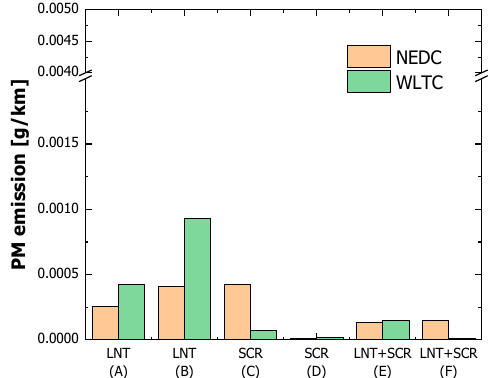
Figure 12. Emission characteristics of test vehicles in New European Driving Cycle (NEDC) and Worldwide Harmonized Light Vehicle Test Procedure (WLTP) modes according to the after-treatment system. ( a ) Measured emission values; ( b ) Average emission patterns.